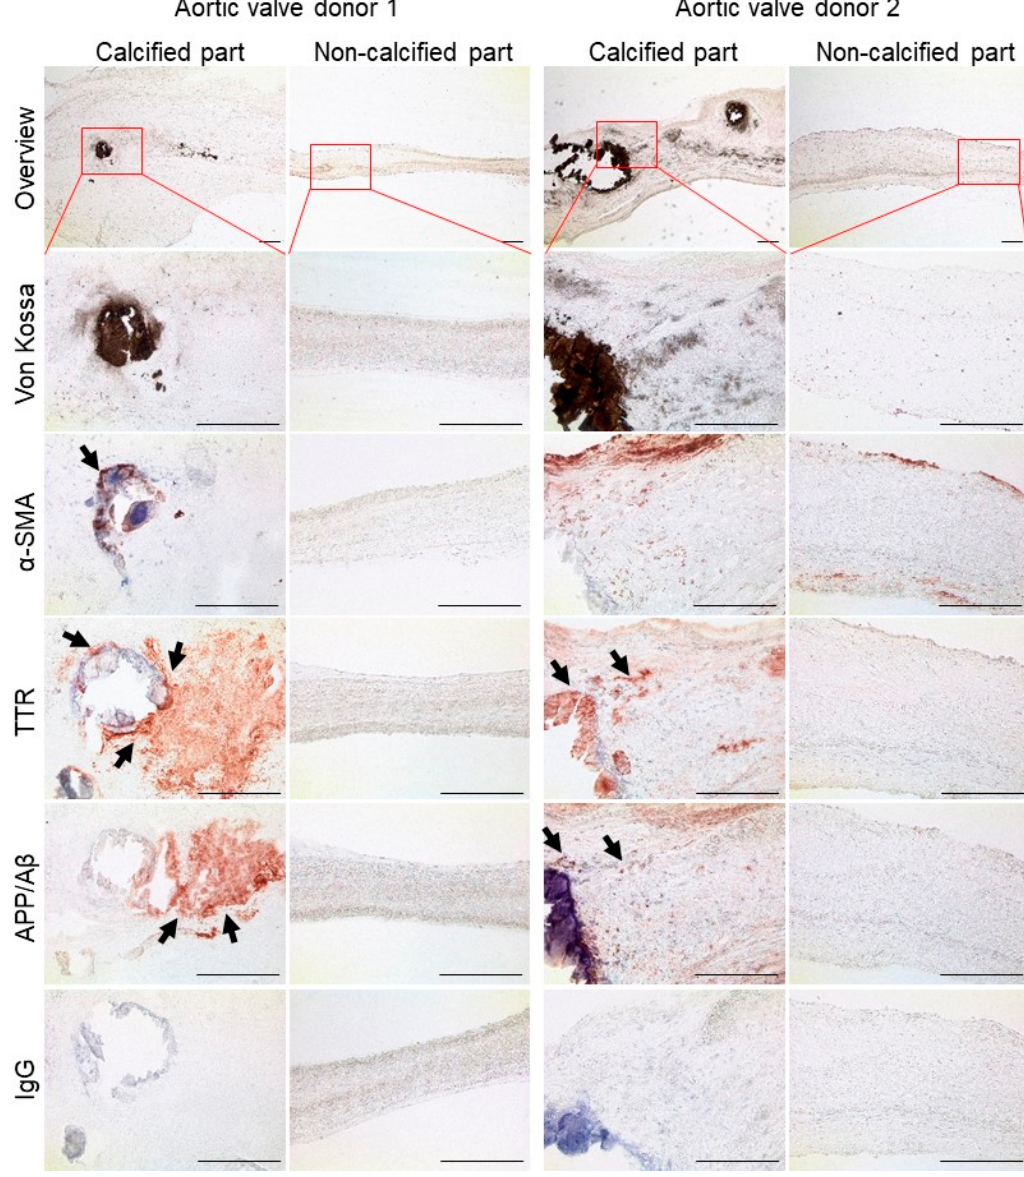
Figure 4. Human calcified aortic valves are transthyretin (TTR) and amyloid precursor protein (APP)/ β -amyloid (A β )-immunoreactive. Aortic valves from patients with aortic stenosis were divided into the calcified and non-calcified portions. Calcification was visualized by von Kossa staining. Immunohistochemistry was performed for smooth muscle alpha-actin ( α SMA), TTR, and APP/A β . Immunoglobulin G (IgG) served as control. One leaflet from each of two donors is shown. The first row shows an overview of the tissue and indicates the respective area of the magnified images. The arrows indicate positive signal. Bar: 200 μ m.